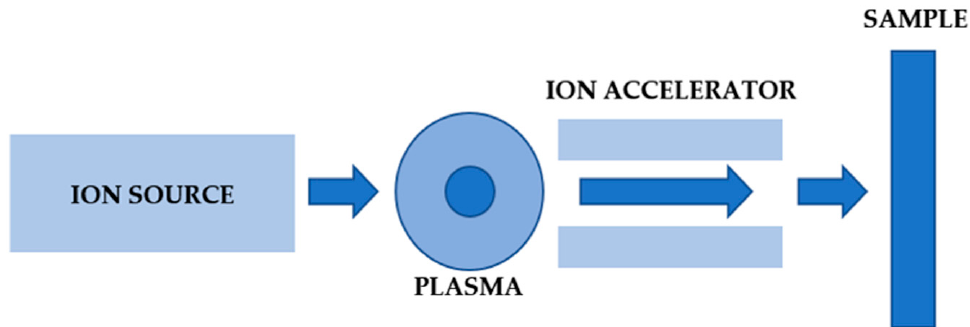
Figure 1. Schematic diagram of an advanced metal ion implantation method. An implantation profile is a measure of the implanted layer thickness. It is a curve defining the distribution of implanted ions at different depths in the base material. The thickness of the resulting layer depends on the properties (atomic weight) of the doped and doping materials, ion energy, ion current density, and doping duration. Due to the kinetic nature of the process, any material can be doped with virtually any element, which enables materials with the assumed functional properties to be obtained. As a result, it is possible to obtain a very high dopant concentration (up to 50%). In addition, the process is characterized by a very high purity and can be carried out at low temperatures [26].